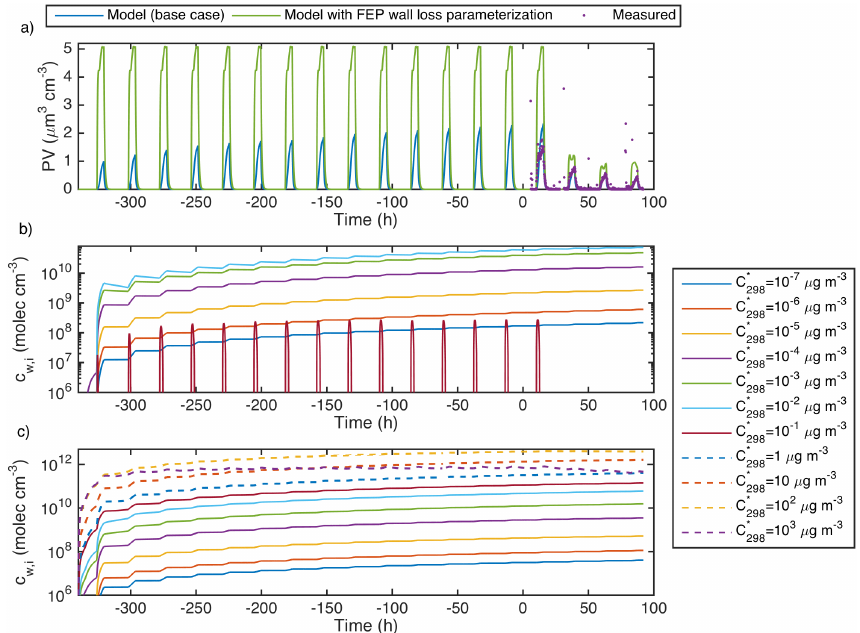
Figure 6. (a) Modelled and measured SOA volume concentration and 2-D VBS VOC wall uptake onto (b) the glass walls (Eqs. 10 and 11) and (c) the PTFE Teflon walls when considering that the PTFE Teflon walls behave as FEB Teflon walls (Eqs. 9, 12 and 13). The VOCs are summed over the all O:C but divided into the different C ∗ bins in the 2-D VBS. At time 0h the intensive measurement campaign started. 298 (a) also shows the modelled SOA volume concentration when assuming that all chamber walls behave as FEP Teflon walls using Eqs. (8) and (9), k e = 4 . 2s − 1 and the VOC FEP Teflon wall mass accommodation coefficient parameterization from Zhang et al. (2015). ELVOC formation from Reactions (R1) and (R2) was not considered for the